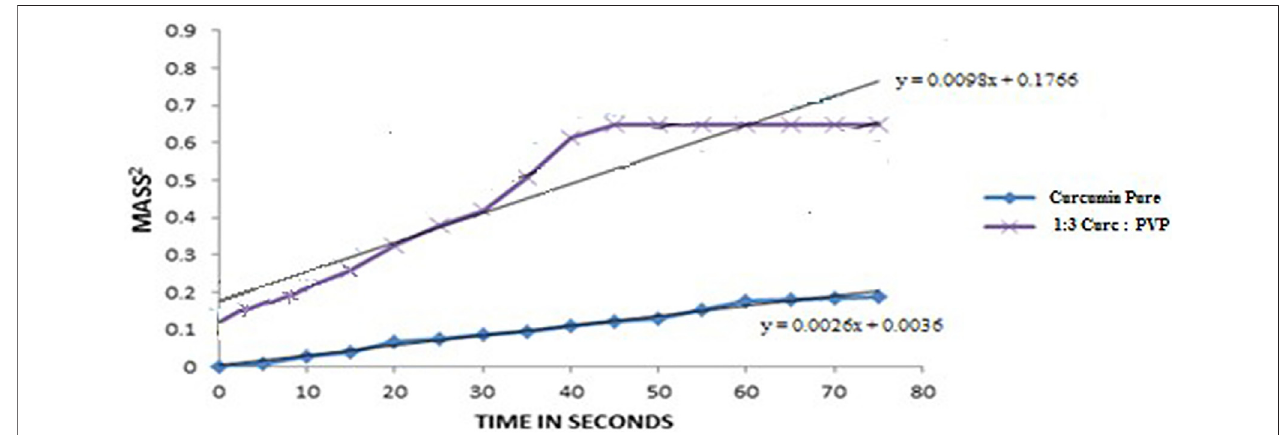
FIGURE 3 | Washburn graph displaying the slopes of CMN pure drug and 1:3 ratio CSDs prepared with PVP K30.